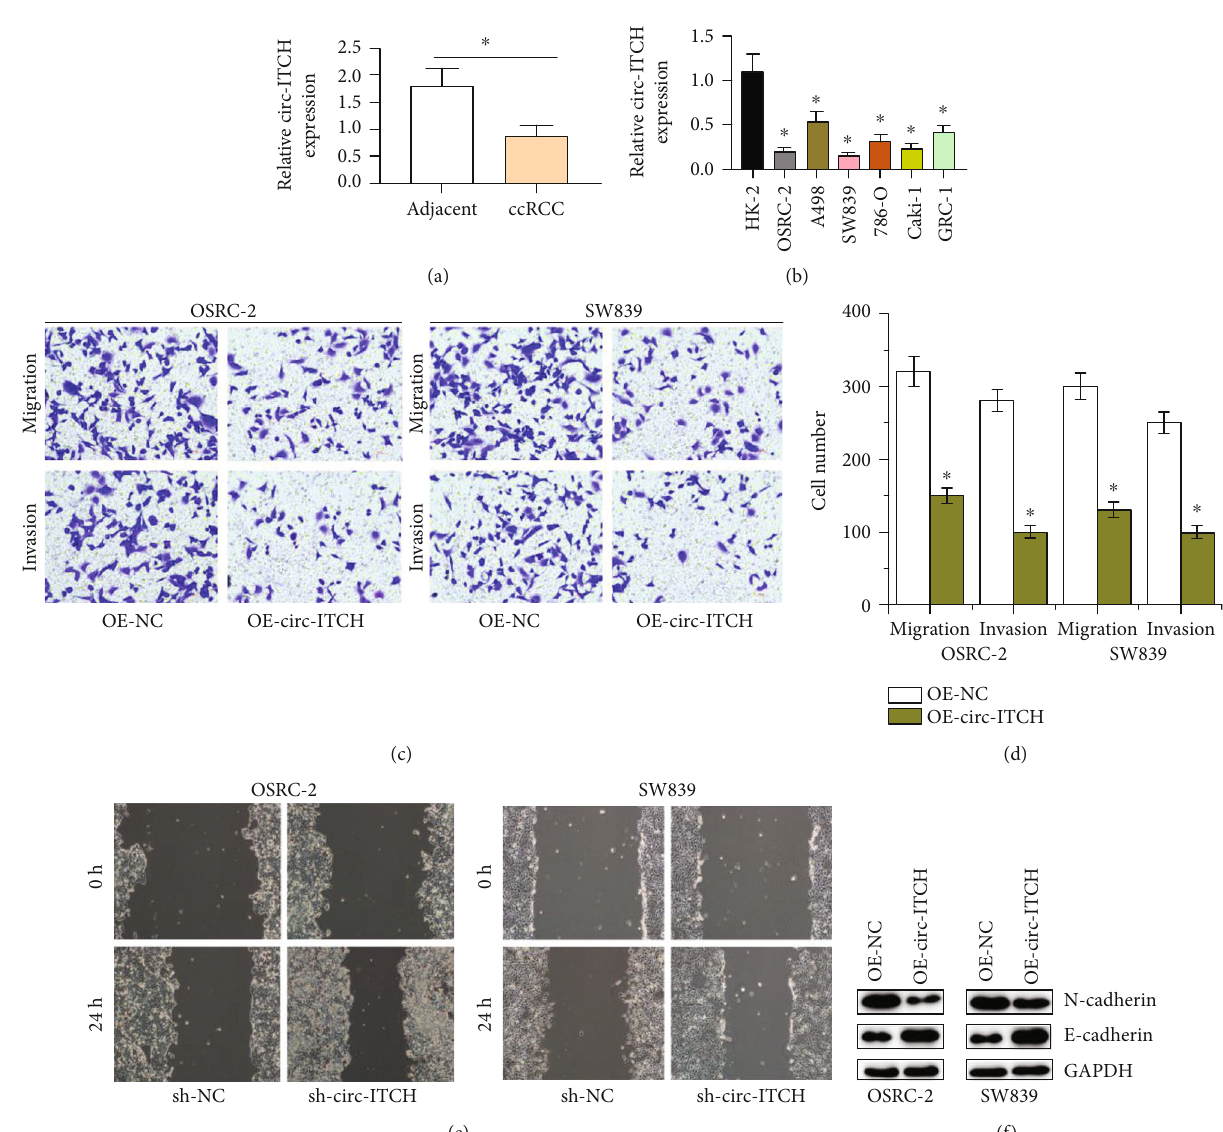
Figure 1: circ-ITCH inhibits ccRCC cell migration and invasion. (a, b) The expression of circ-ITCH in ccRCC tissues and cells by qT-PCR. (c, d) Transwell assay determines the role of circ-ITCH in migration and invasion of OSRC-2 and SW839 cells. (e) Wound healing detects the e ff ect of circ-ITCH downregulation on the migration abilities of OSRC-2 and SW839 cells. (f) The expressions of E-cadherin and N-cadherin in OSRC-2 and SW839 cells transfected with